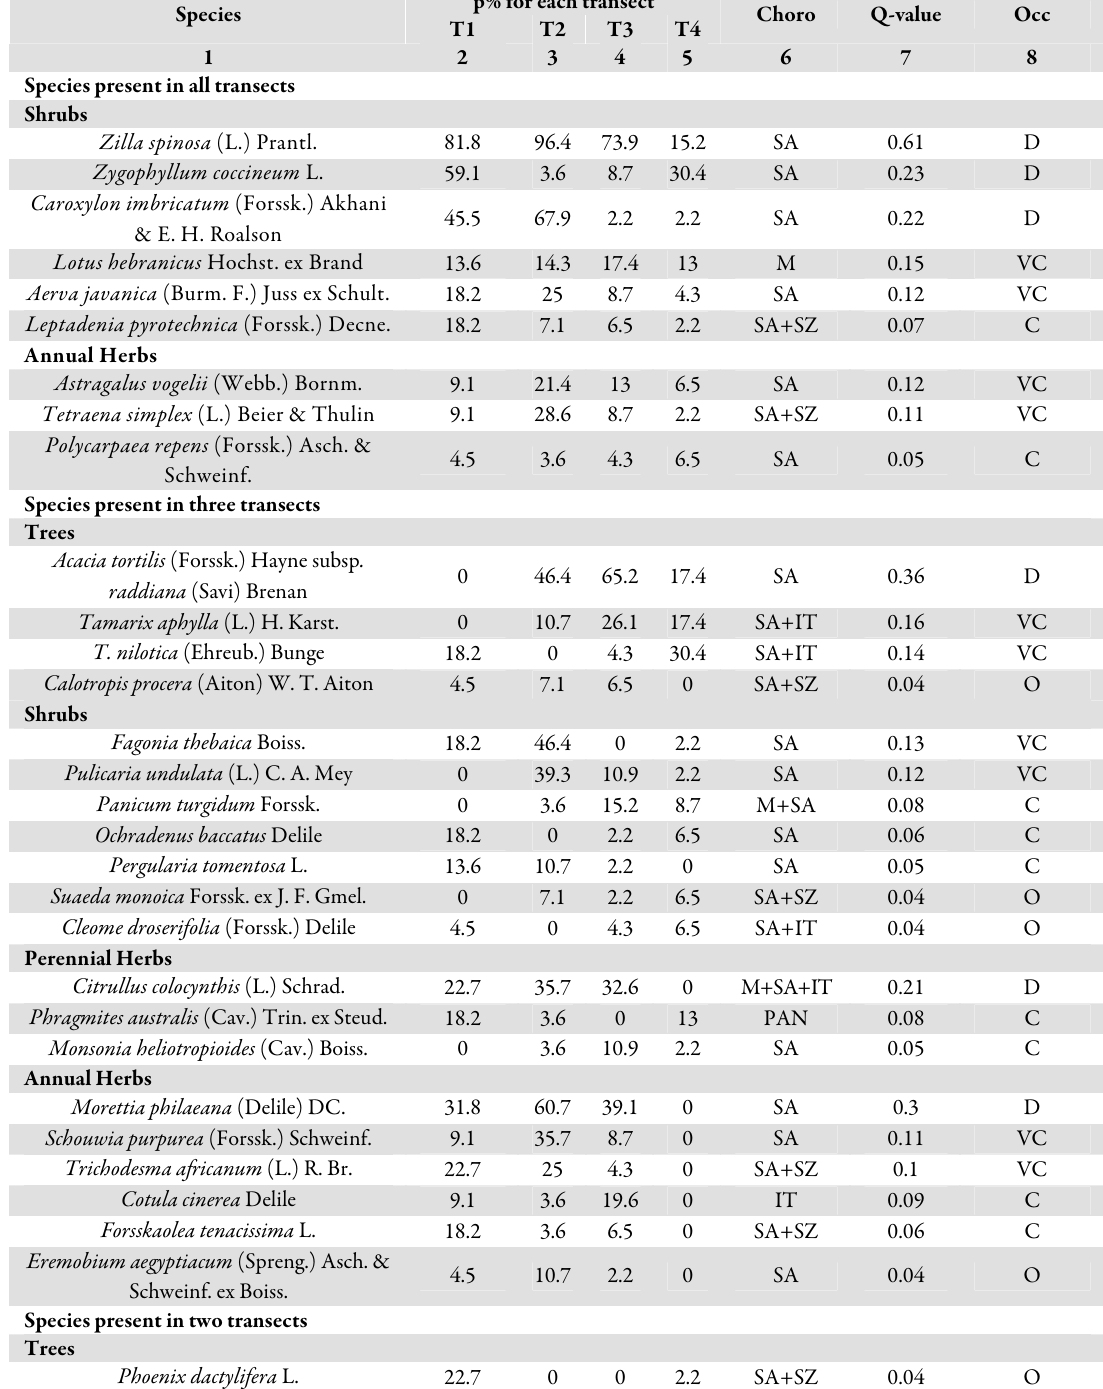
Tab. 1. Species composition of the 4 transects classified according to the different functional groups, together with their presence values (P%), chorology, Q-values and occurrences. T1= Qena-Safaga transect; T2= Idfu-Marsa Alam transect; T3= Aswan-Kharit-Gimal transect and T4= Red Sea transect. Choro= Chorology (SA= Saharo-Arabian, SZ= Sudano-Zambezian, M= Mediterranean, IT= Irano-Turanian, ES= Euro-Siberian, SU= Sudanian, GC= Gueno-Cungo, COSM= Cosmopolitan, PAN= Pantropical, PAL= Palaeotropical). Occ= Occurrence (D=Dominant, VC=Very common, C=Common, O=Occasional,